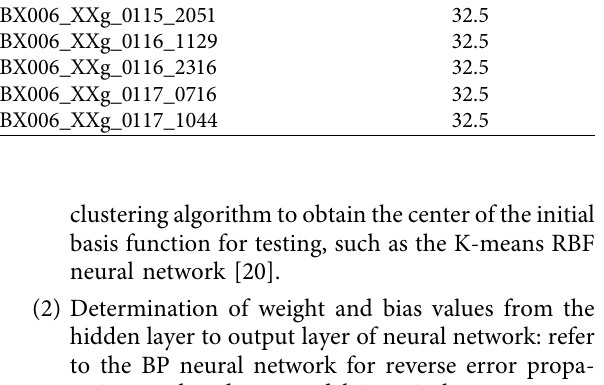
Table 6: Optimal refrigerant amounts. Data